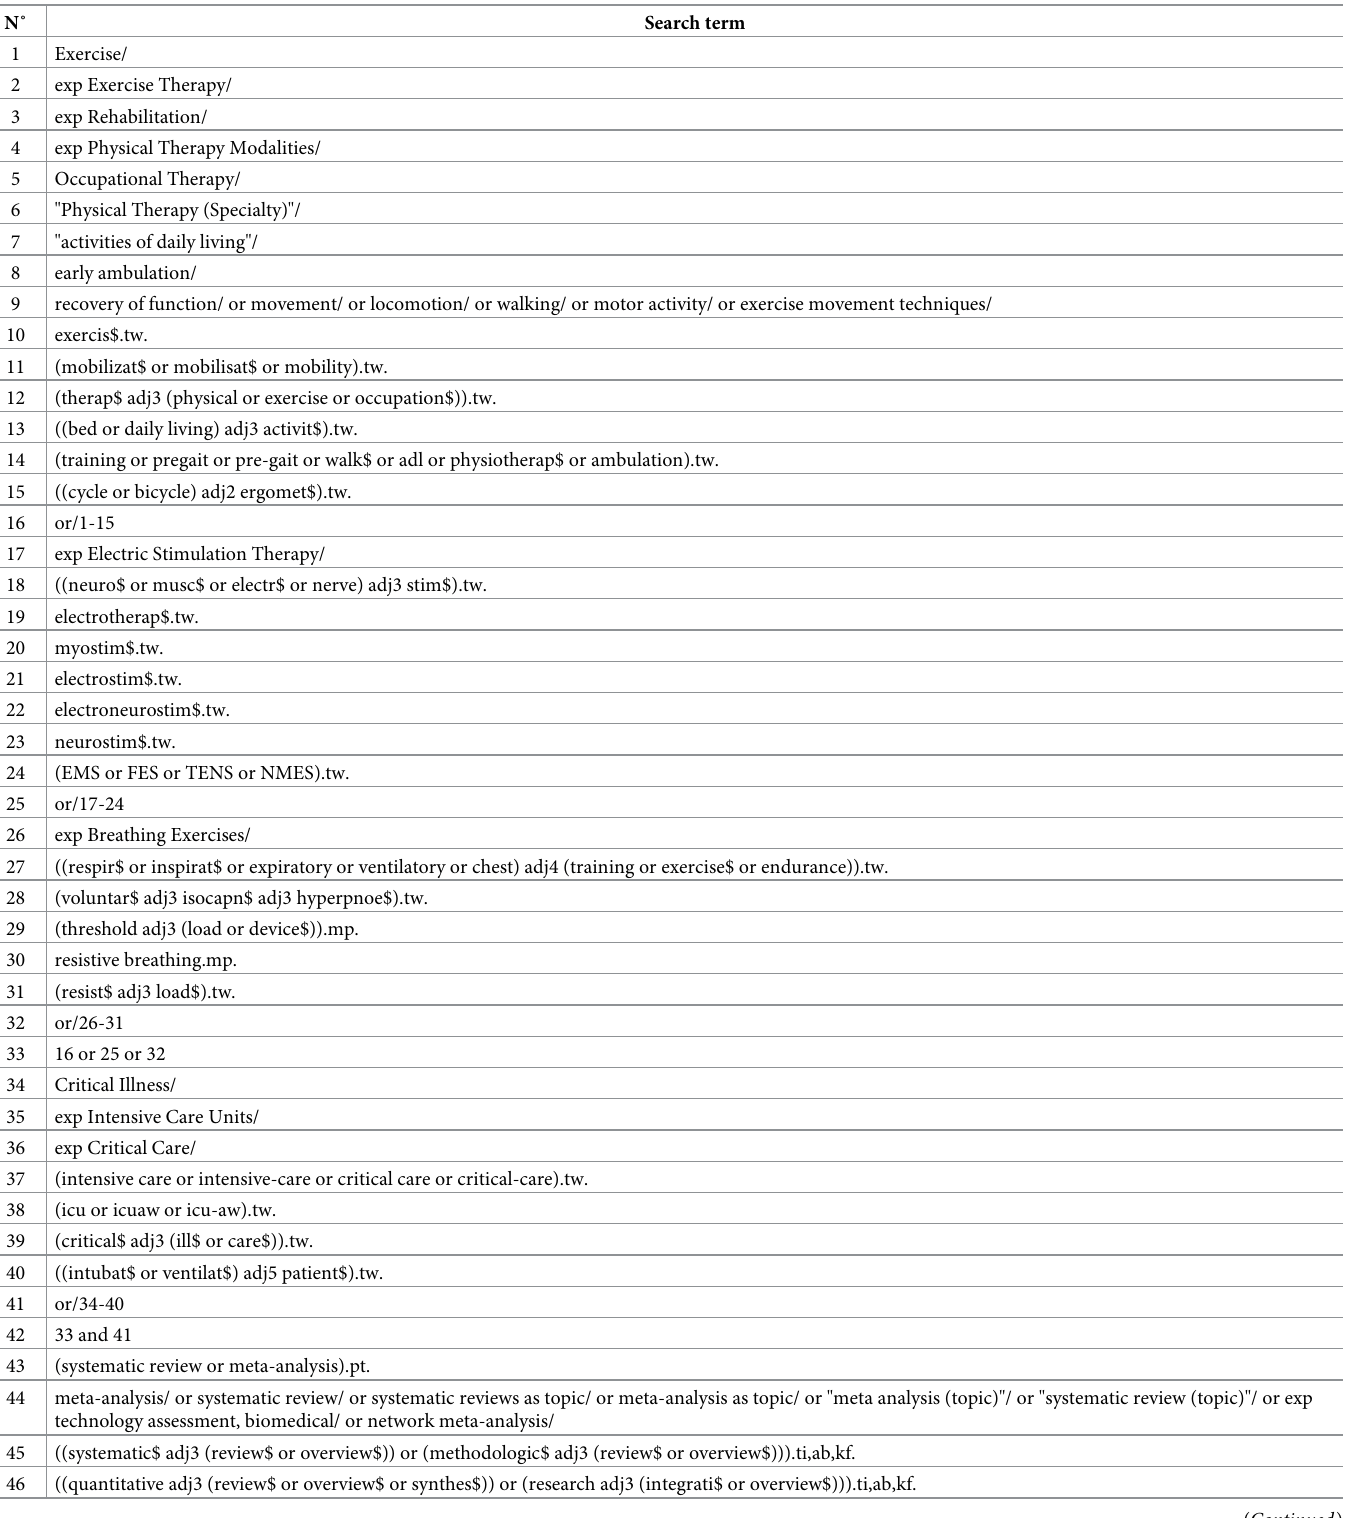
Table 1. Search strategy for MEDLINE